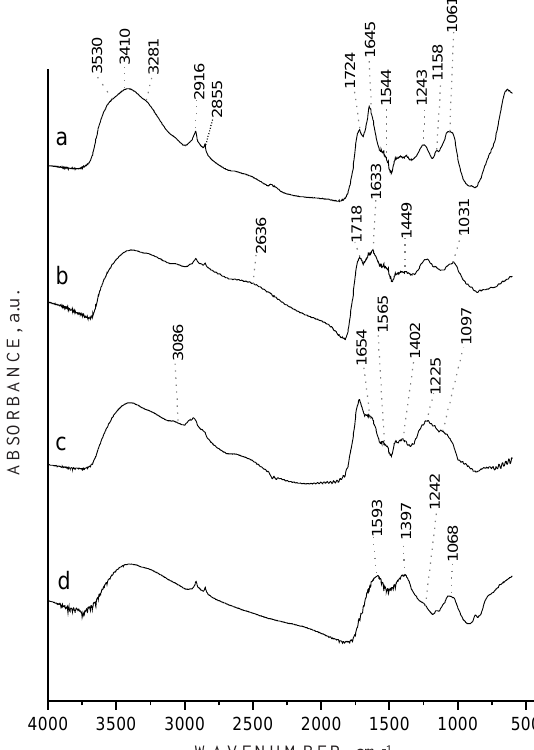
WAVENUMBER, cm Figure 5. Transmission FTIR spectra of SOM (a) and its fractions: HA (b), FA (c) and HU (d) of the Chernosol.